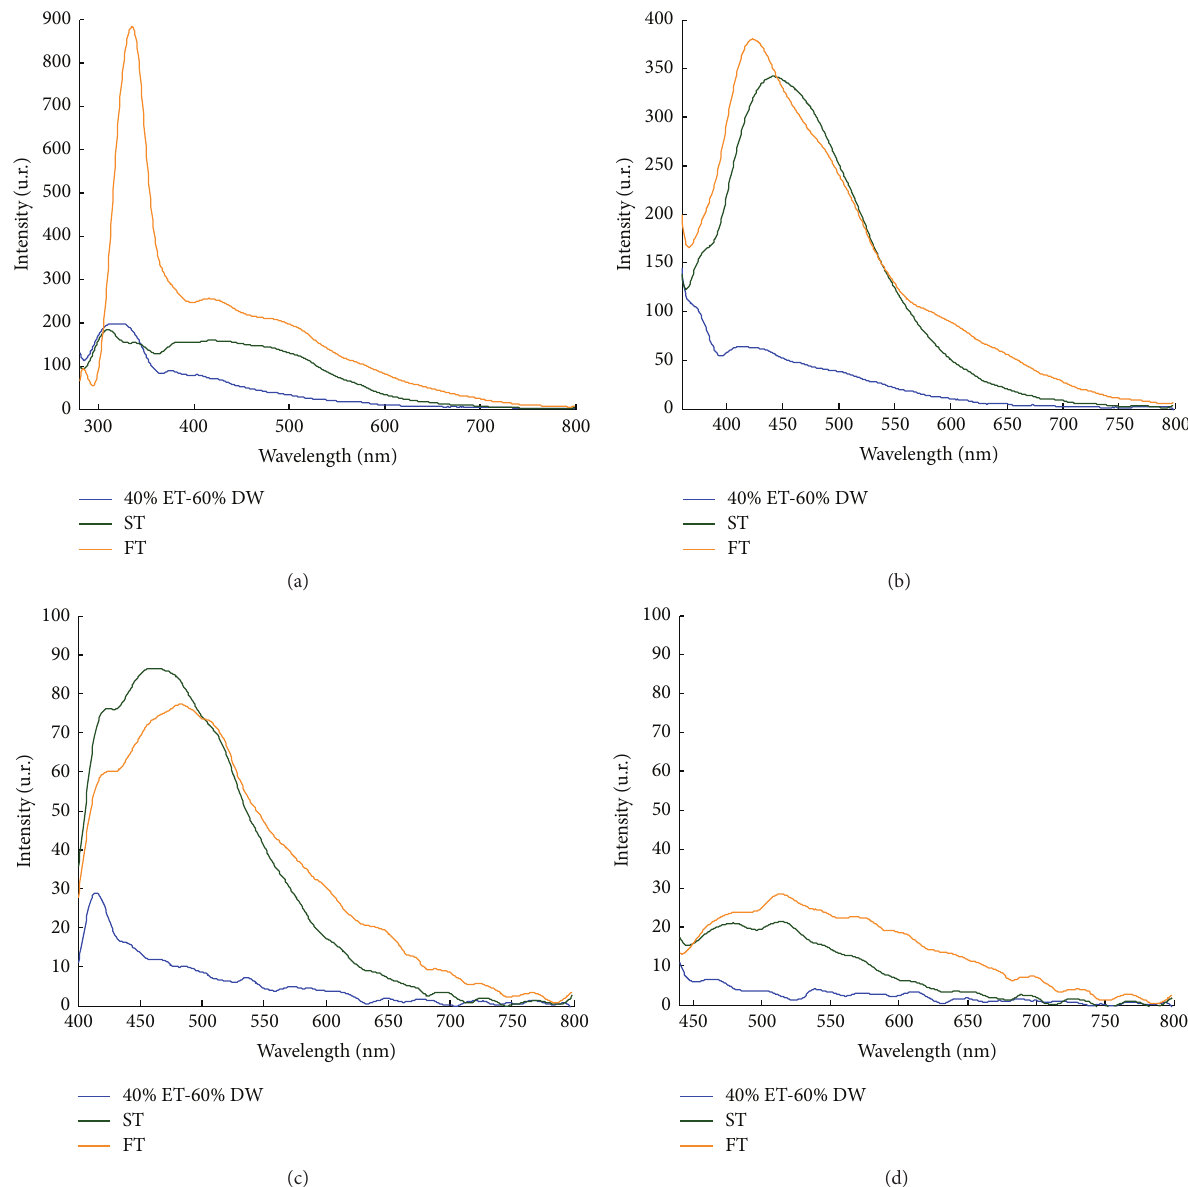
Figure 6: Fake tequila fluorescence (FT) compared to ET-DW (40%-60%) and ST fluorescence at different wavelengths. (a) 255 nm, (b) 330 nm, (c) 365 nm, and (d) 405